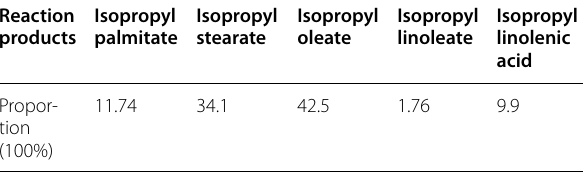
Table 6 Composition ratio of esterification reaction